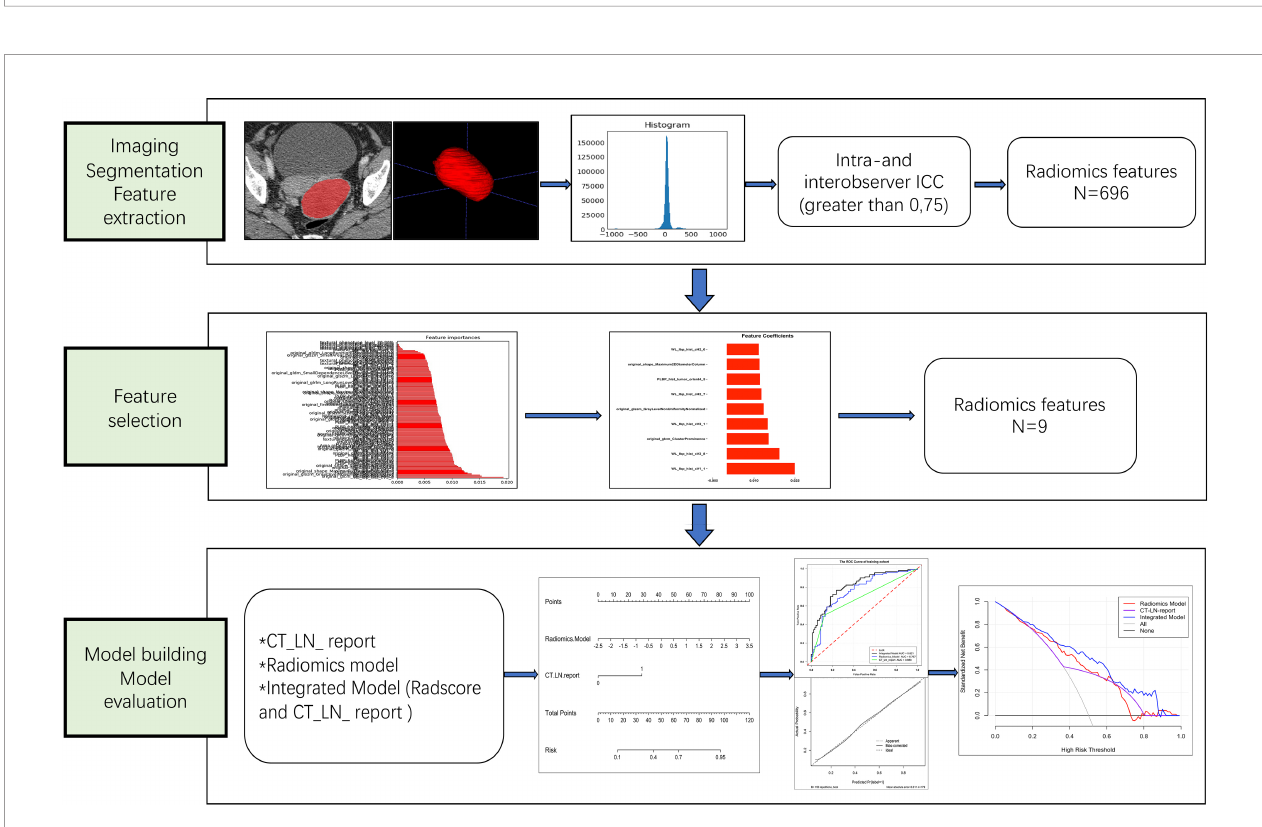
FIGURE 2 | Work fl ow of the steps in our study. First, tumors were manually segmented, and radiomic features were extracted from within the de fi ned tumor contours on CT images. Second, for feature selection, the random forest method was used to rank the remaining features in order of importance according to different kinds of permutations and combinations. Finally, the performance of the radiomics nomogram was developed based on the Radscore and CT_LN_report in the training cohort and assessed by ROC curve, calibration curve, and decision curve analyses.